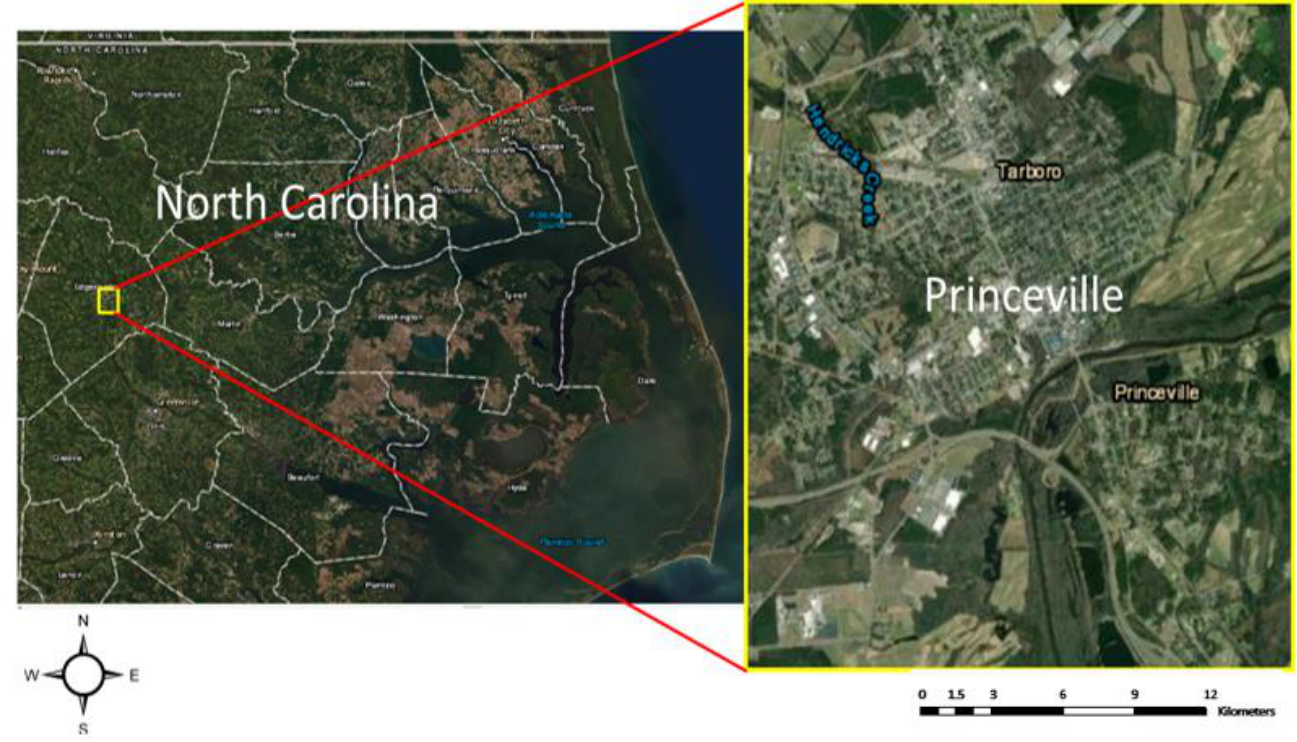
Figure 1. Study area—Princeville, North Carolina.